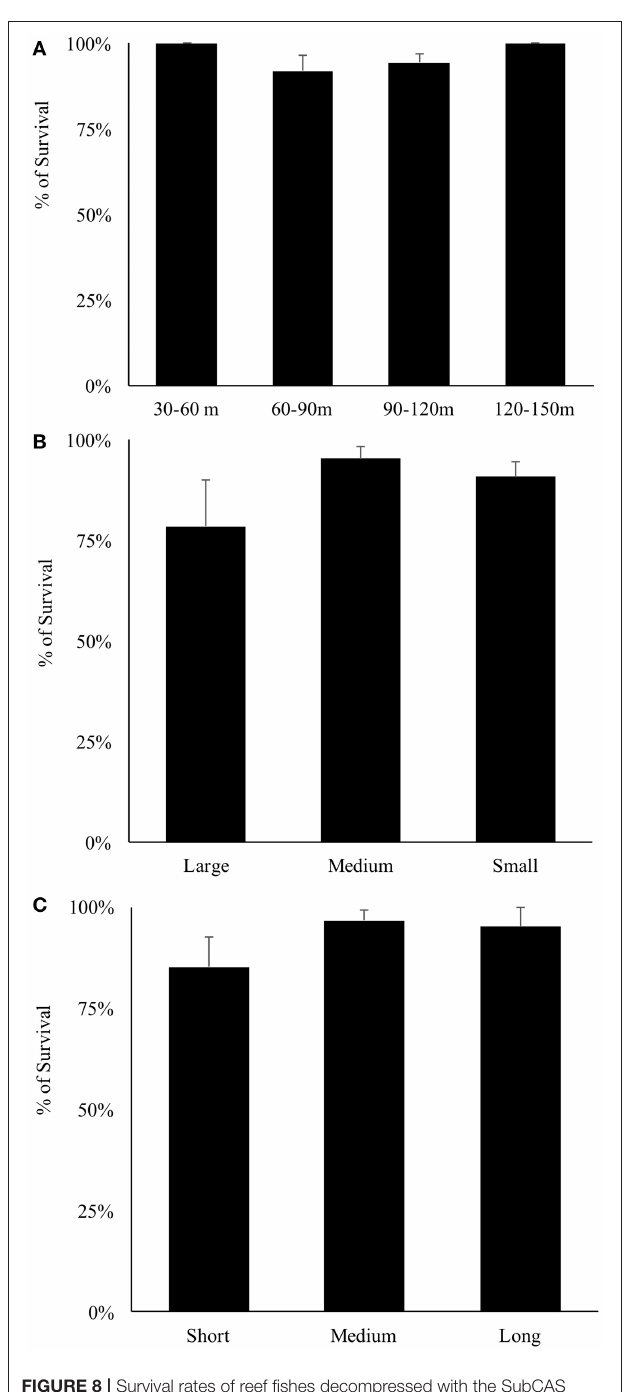
FIGURE 8 | Survival rates of reef fishes decompressed with the SubCAS chamber. (A) Depth range of collection; (B) Fish size classes: small (0–5cm TL), medium (5–10cm TL) and large (10–15cm TL); (C) Decompression time: short (1,000–2,000min), medium (2,000–4,000min) and long